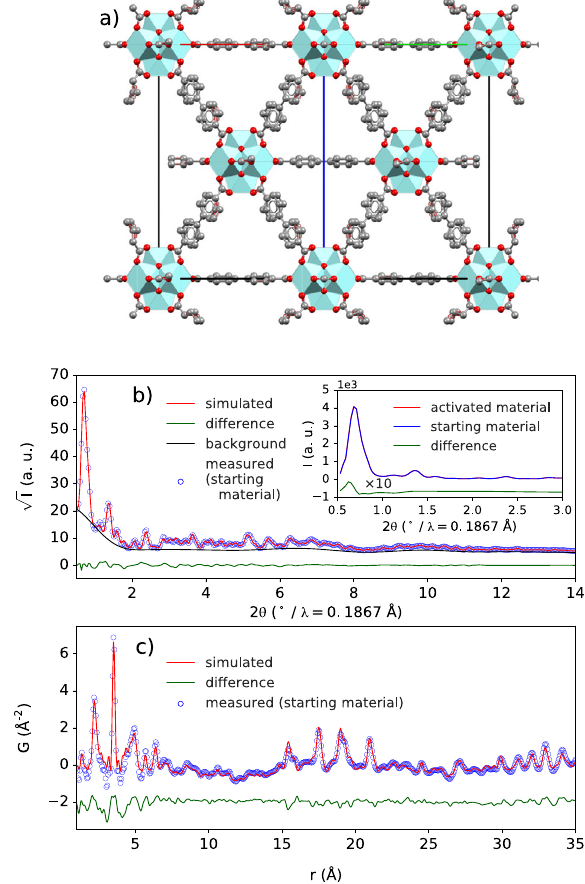
Fig. 1 UiO-67 structure re fi nements. a The Zr 6 O 8 clusters coordinated by 12 BPDC ligands in a 3D network with F 432 space group (along the [110] direction). b Resulting fi t from Rietveld re fi nement ( R w = 5.18%) for activated UiO-67. The inset shows a comparison of the diffraction patterns before and after activation and suggests only a slight change in relative intensity of the fi rst Bragg peak which contains contributions from 111 and 200. c Fit from real-space structure re fi nement ( R w = 26%) to the measured PDF of activated